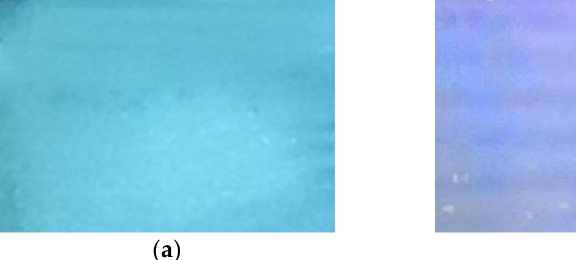
Scheme 1. Schematic diagram of the PEI-CdS QD-embedded photonic crystal hydrogel preparation process. ( a ) Preparation of photonic crystal template, ( b ) preparation of QD-embedded photonic crystal hydrogel.